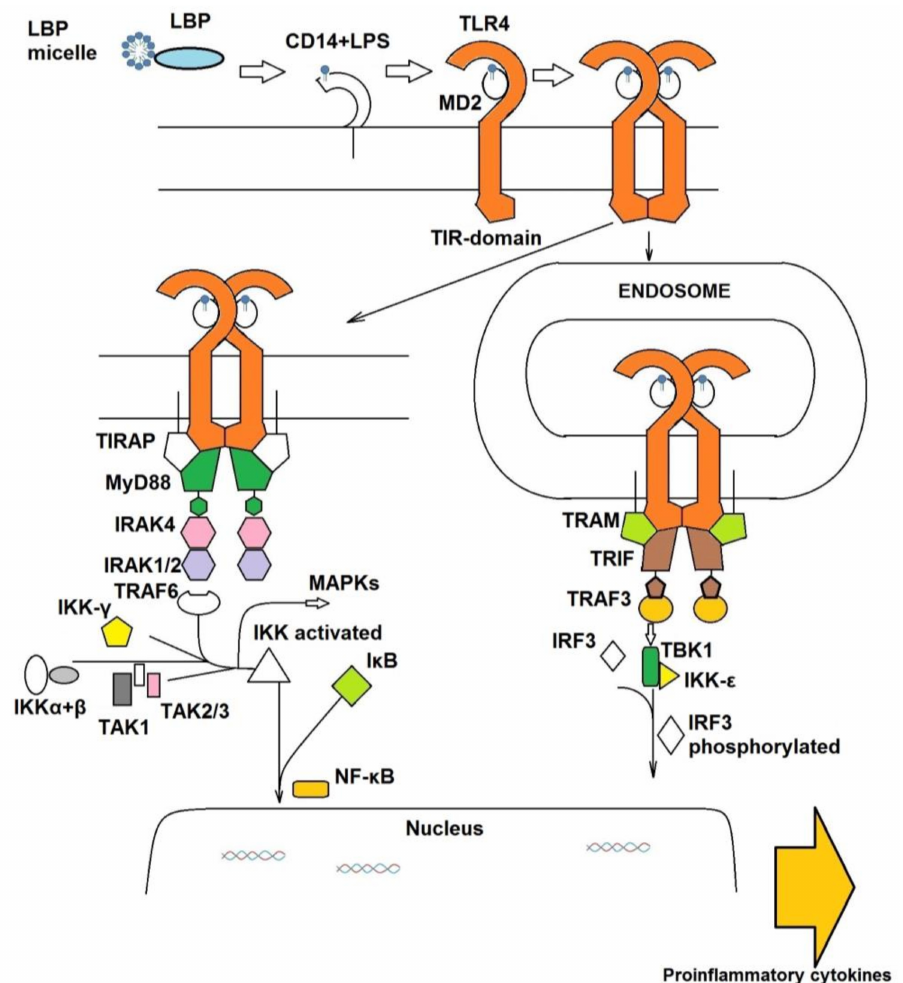
Figure 1. The lipopolysaccharide (LPS)/toll-Like Receptor 4 (TLR4) signaling pathway: the extracellular part (mediated by LPS-binding protein (LBP), cluster of differentiation 14 (CD14) and MD-2) and the intracellular part (myeloid differentiation primary response gene (MyD88) and TIR-domain-containing adapter-inducing interferon- β (TRIF)